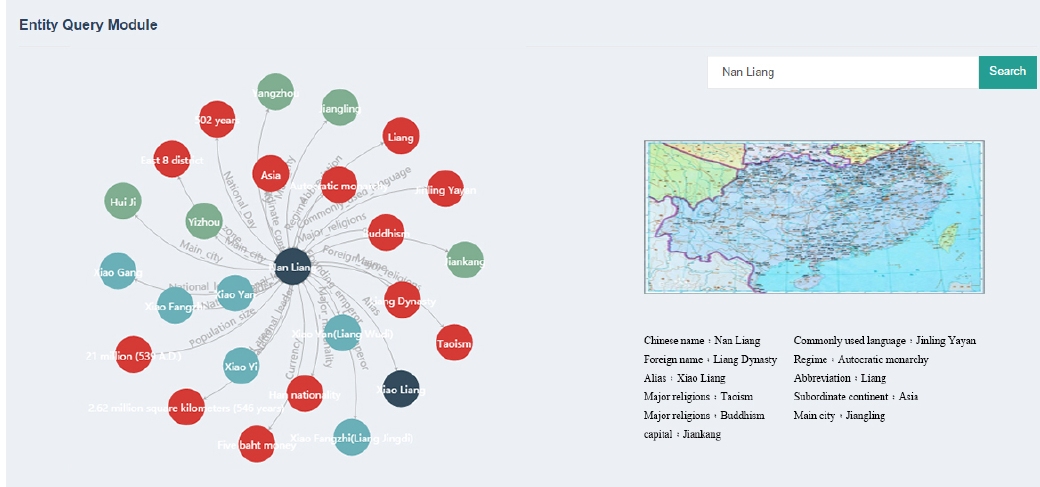
Figure 14. Entity attribute knowledge query module, the left is the force-oriented diagram of the query entity, and the right is the encyclopedia introduction of the query entity.